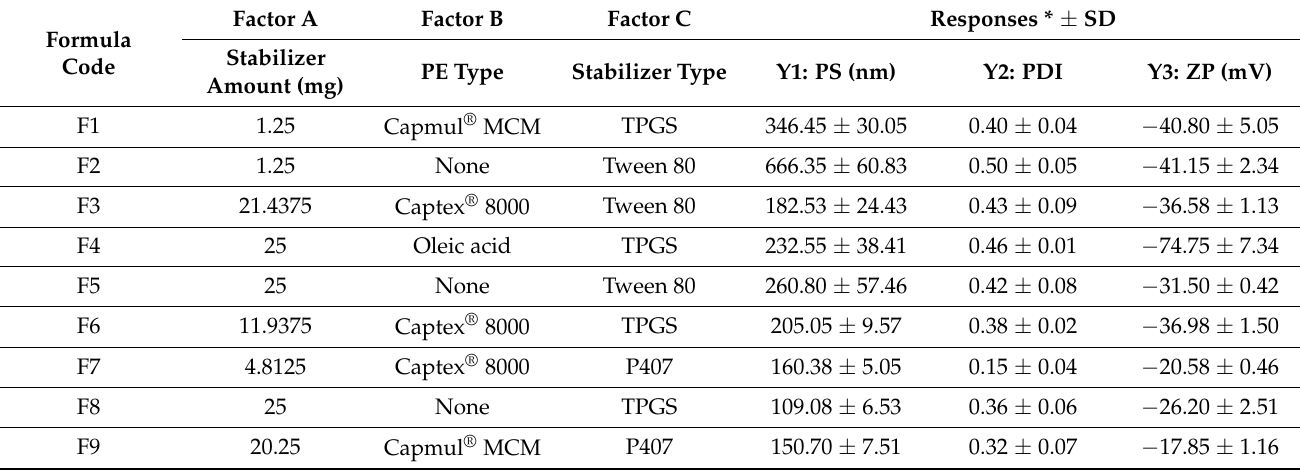
Table 1. The results of dependent variables of the prepared liquid crystalline nanostructures formulae based on the D-optimal